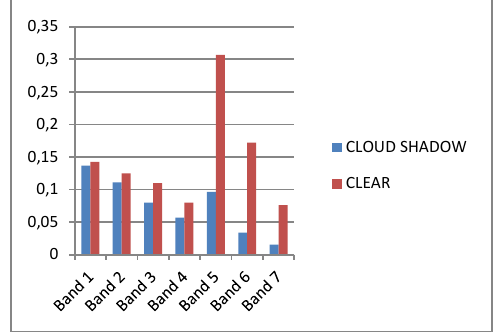
Figure 4. The difference of reflectance values between clear pixels and cloud shadow contaminated pixels on vegetation.